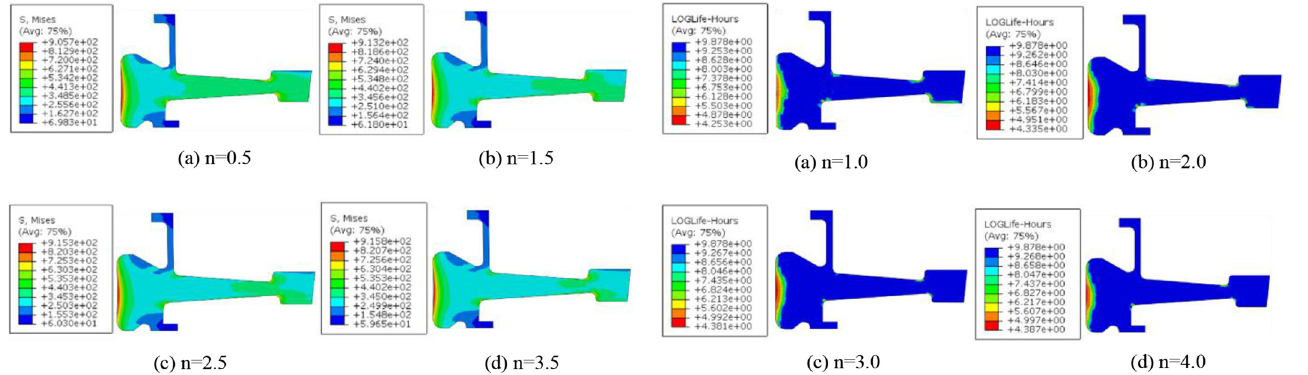
Fig. 12. Simulation results of FGM turbine disc in cruising state: Table 12. Logarithmic fatigue lives of turbine disc for different n